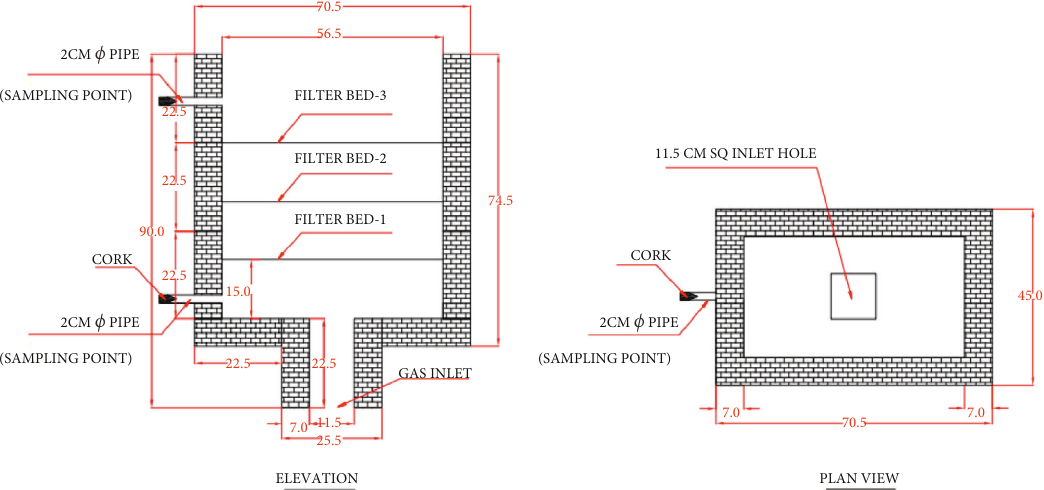
Figure 2: Elevation and plan views of smoke filter unit